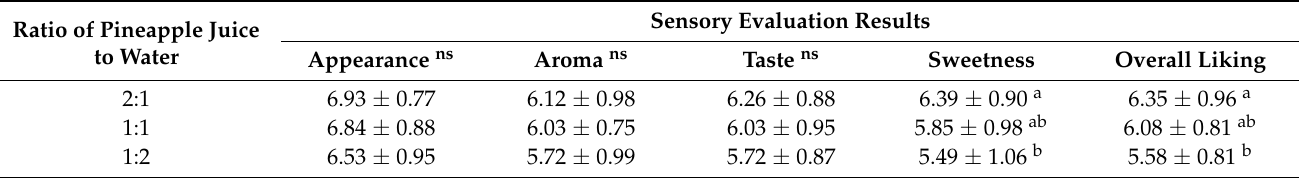
Table 3. Sensory evaluation of pineapple wine with various pineapple juices to water ratios.